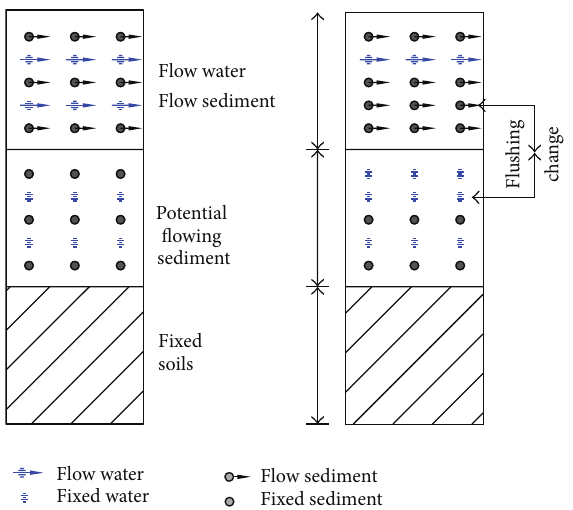
Figure 1: Schematics of particle exchange and transport of under- ground sediment.